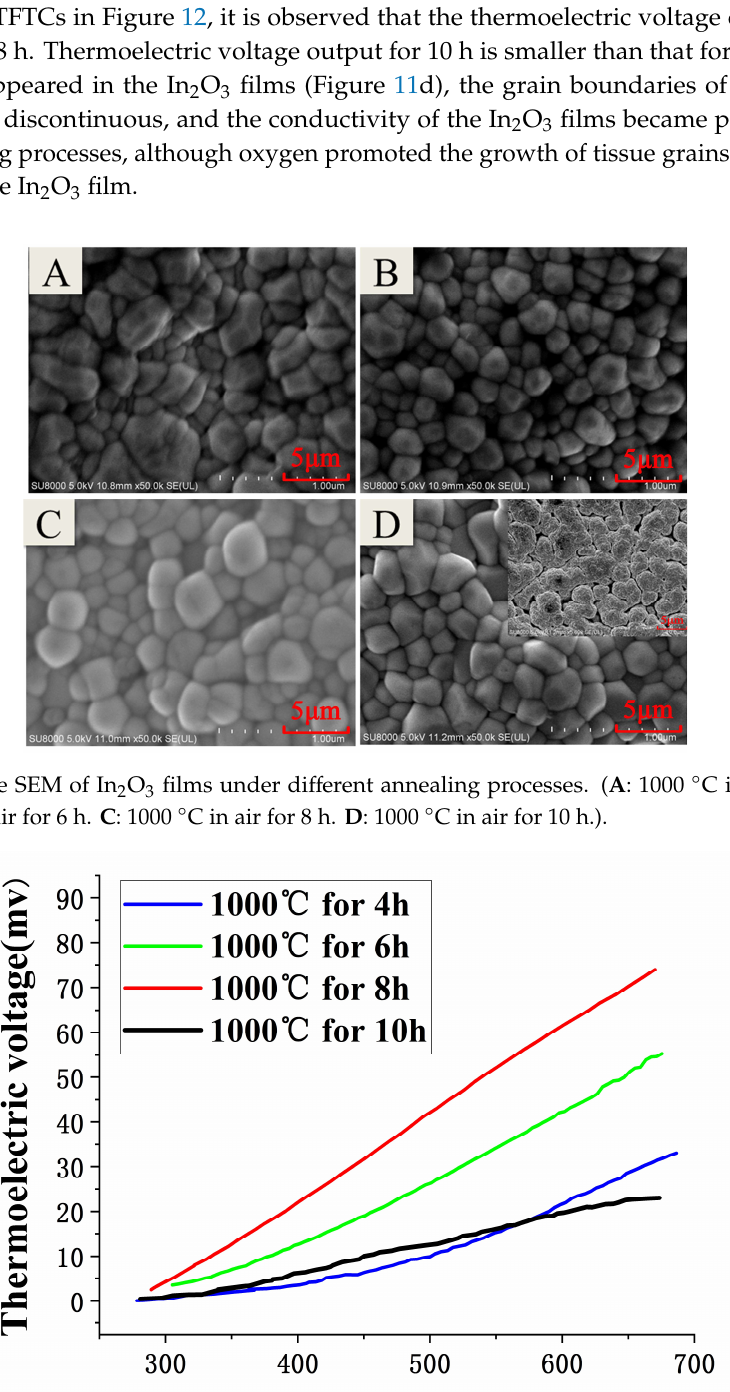
Figure 12. Thermoelectric voltage output of TFTCs.